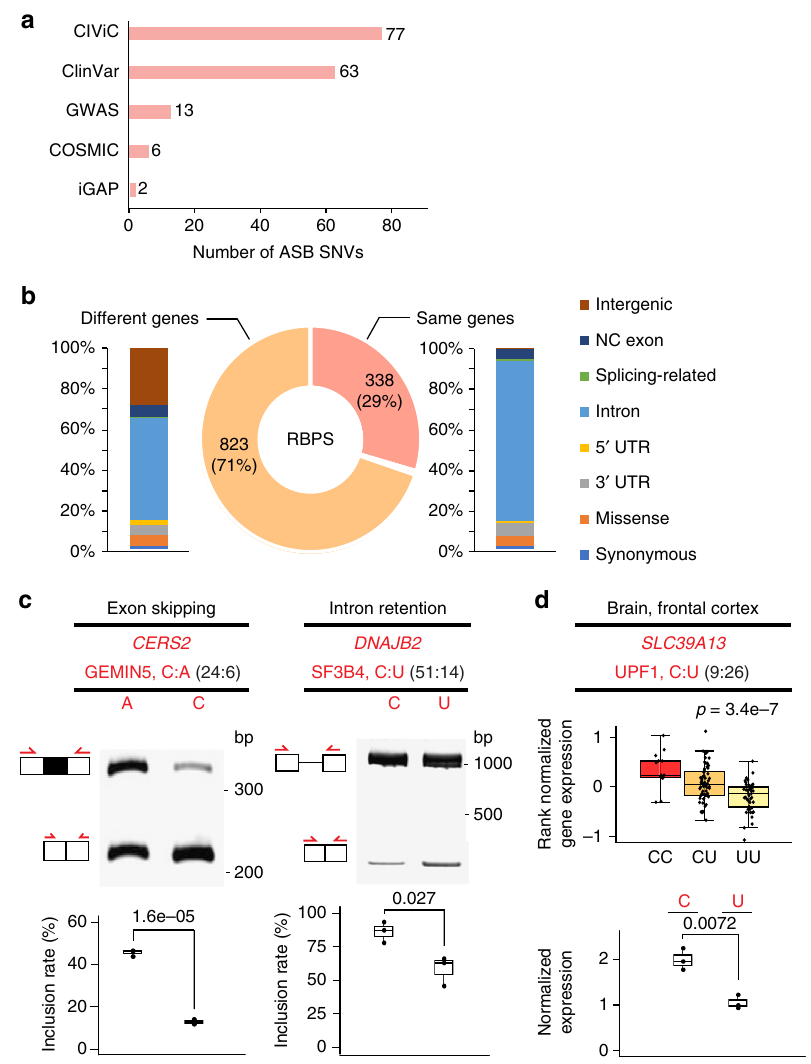
Fig. 6 Allele-speci fi c binding (ASB) events inform functional interpretation of disease-associated variants. a Numbers of ASB single-nucleotide variants (SNVs) that are also disease-related SNVs annotated by different databases. b Genomic context of genome-wide association study (GWAS) single- nucleotide polymorphisms (SNPs) (stacked bars) located in the same or different genes as ASB SNVs. Most GWAS SNPs are located in introns, whose function was elusive. NC exon: exons in non-coding transcripts. Splicing-related: those located in splice site signals. c Splicing reporter validation of two ASB SNVs, similar as Fig. 4e. (Images are cropped, with uncropped images in Supplementary Figure 16.) d Minigene reporter validation of one SNP for its function in modulating messenger RNA (mRNA) abundance, similar as Fig. 5e. Boxplot center lines indicate the median and the boxes extend to lower and upper quartiles with whiskers depicting 1.5 inter-quartile range (IQR). (Source data are provided as a Source Data fi